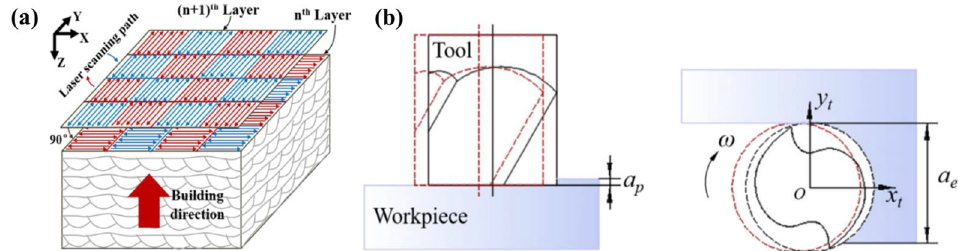
Figure 3 Schematics of a the scanning strategy for SLM and b for HSM